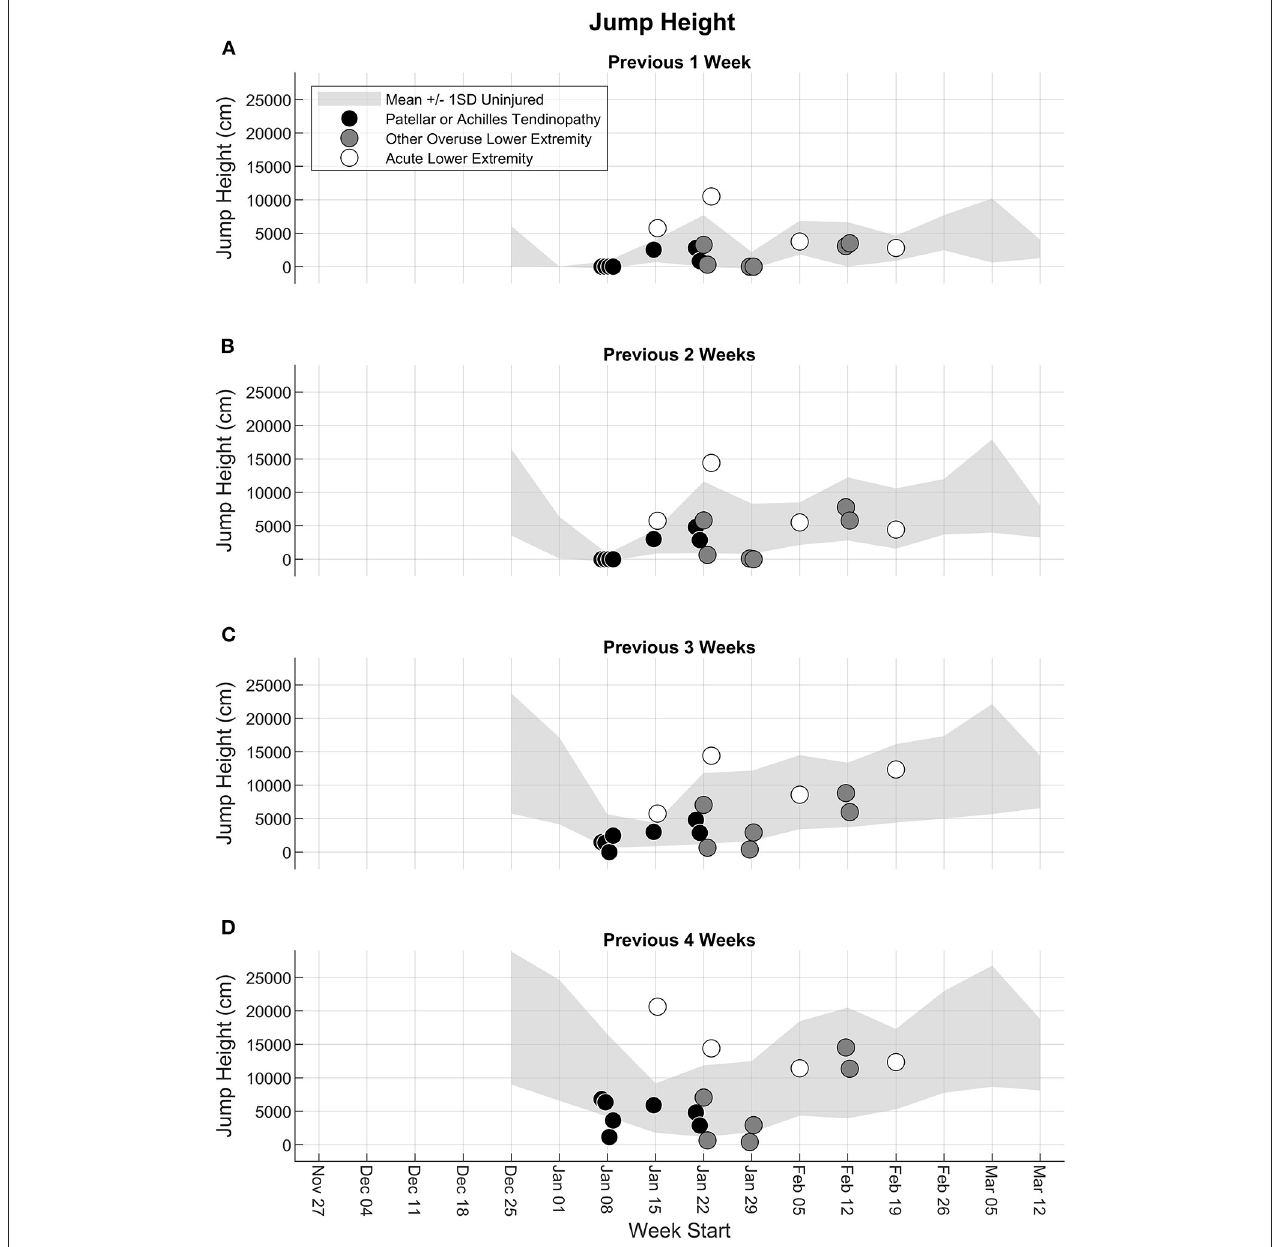
FIGURE 4 | Accumulated jump height from the fifth week to the end of the season for the previous (A) 1 week, (B) 2 weeks, (C) 3 weeks, and (D) 4 weeks. Light gray shaded band represents the mean ± 1 standard deviation (SD) of all participants until the last week where they did not experience any injury. Participants with a lower extremity injury are shown separately in the week in which their first injury was reported, and the injury type is indicated as patellar or Achilles tendinopathy (black circle), other overuse lower extremity injury (dark gray circle), or acute lower extremity injury (white